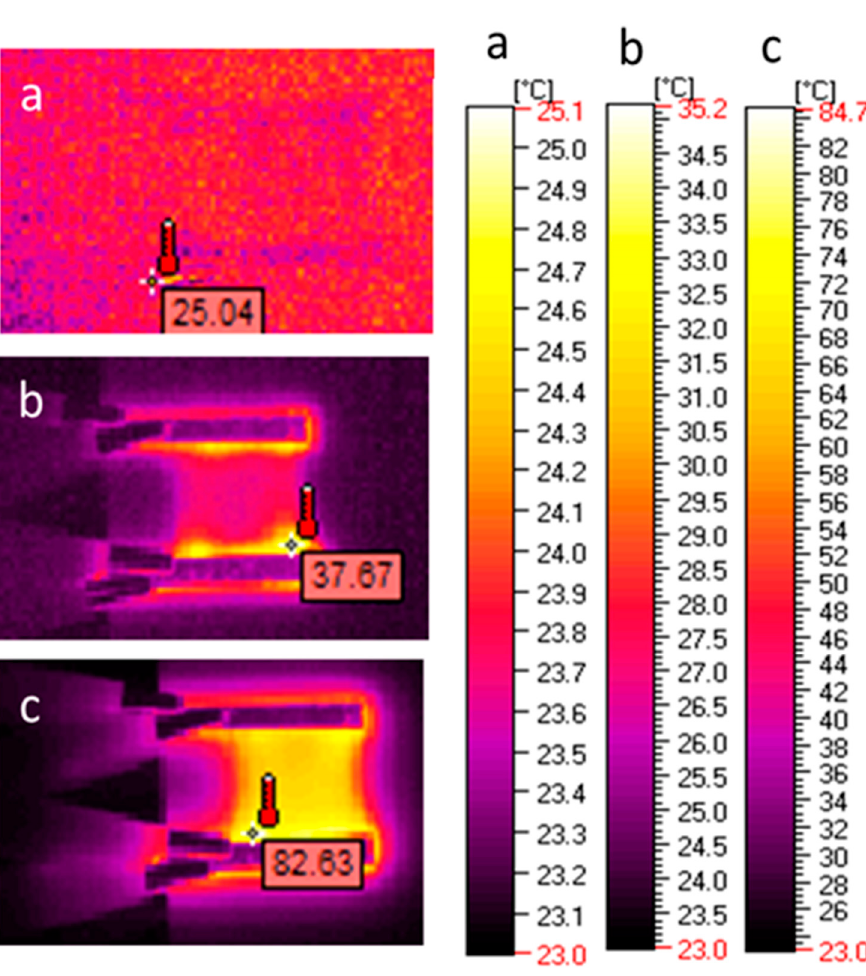
Figure 9. IR mages obtained for L , D -PLA with 5% SWCN under different potential value: 2 V, 0 A ( a ); 11 V, 0.08 A ( b ); and 11 V, 0.3 A ( c ).